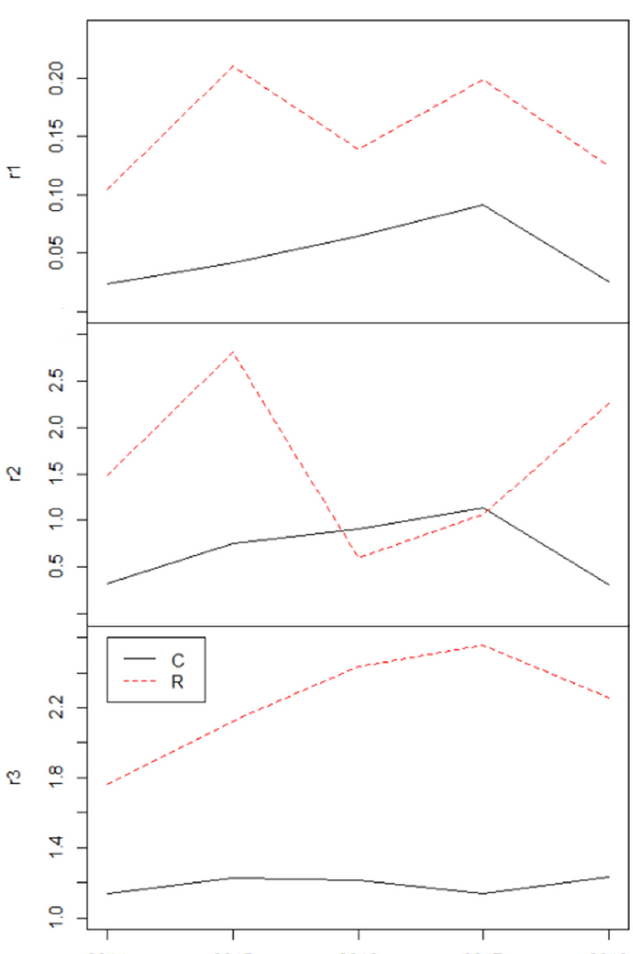
Fig. 5. Line plots for the median of the standard indicators r 1 to r 3 by year and region Notes: C indicates Catalonia and R La